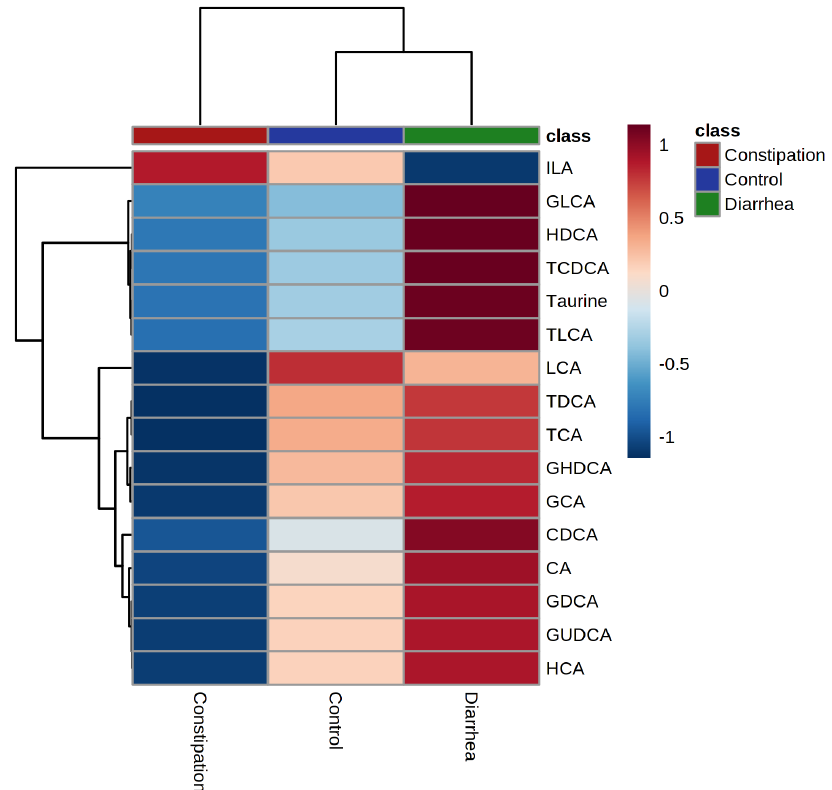
Figure 6. Hierarchical clustering analysis for average values of groups healthy control, constipation (FC + IBS-C) group, and diarrhea (FD + IBS-D) group. Data presented as z score of logged values of µg/mg. Color ribbon beneath upper dendrogram identifies group; healthy control—blue, constipation phenotype—red, diarrhea phenotype—green. Constipation group is defined as individuals with both functional constipation and IBS-C. Diarrhea group is defined as individuals with both functional diarrhea and IBS-D.